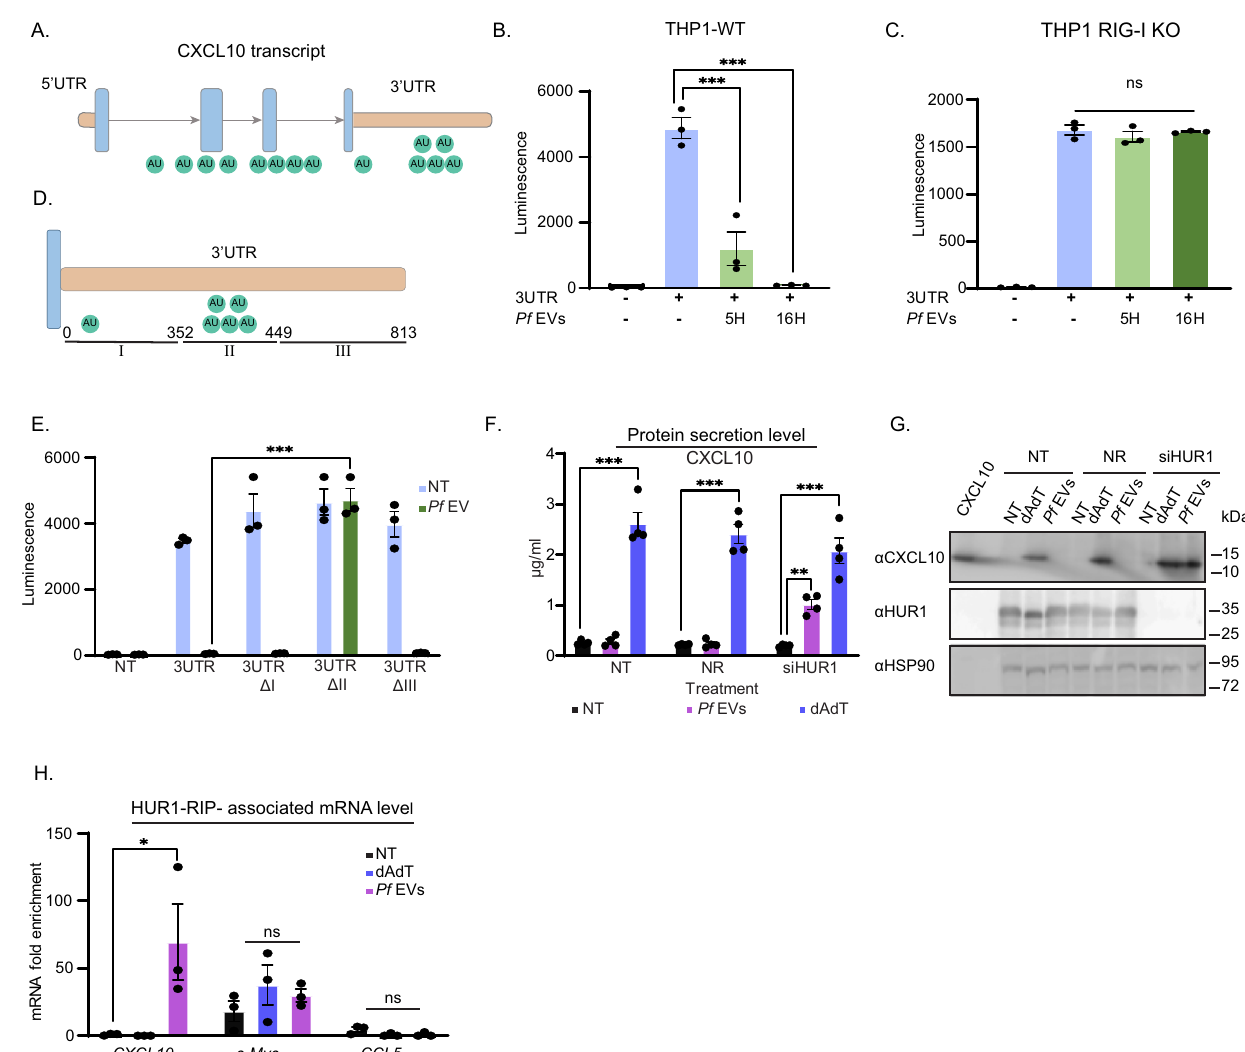
Fig. 4 HUR-1 binds to AU- rich domain in the 3 ′ UTR of the CXCL10 transcript and is involved in translation inhibition. A Schematic illustration of CXCL10 mRNA. Orange squares, blue rectangles, and gray arrows represent the UTRs, exons, and introns of the CXCL10 mRNA, respectively. The green circles illustrate the AU-rich domains predicted by http://arescore.dkfz.de/ analysis. B THP-1 cells were incubated with Pf- derived EVs 5 or 16 h (H) or not treated before the transfection with the CXCL10 -3 ′ UTR-Luc plasmid. 24 h post transfection, the cell media was collected, luciferase levels were measured and normalized to SEAP levels. n = 3 biologically independent experiments, SEM, one-way ANOVA followed by Dunnett ’ s test, (3UTR + Pf EVs 16 h - *** P < 1e-04, 3UTR + Pf EVs 5 h - 3UTR *** P < 1e-04). C THP-1 RIG-I KO cells were incubated with Pf- ring-stage - derived EVs for 5 or 16 h (H) or not treated (NT) before their transfection with the CXCL10 -3 ′ UTR-Luc plasmid. 24 hours post transfection, the cell media was collected and luciferase levels were measured and normalized to the SEAP levels. n = 3 biologically independent experiments, SEM, one-way ANOVA followed by Dunnett ’ s test (ns). D Schematic illustration of the three sub-domains of CXCL10 3 ′ UTR and the cloned deletions Δ I, Δ II, and Δ III. E THP-1 cells were treated with Pf -derived EVs for 16 h prior to transfection with CXCL10 3 ′ UTR-fused-reporter, Δ I, Δ II, Δ III plasmids (NT-not treated cells). 24 hours post-transfection the cells media was collected, Luciferase levels were measured and normalized to the SEAP levels. n = 3 biologically independent experiments, SEM, one-way ANOVA followed by Dunnett ’ s test, ( Pf EVs- 3UTR Δ II - 3UTR *** P < 1e-06). F THP-1 cells were transfected with siRNA for HUR1 or with non-targeting siRNA pool (NR). 48 hours post siRNA transfection, cells were treated with Pf -derived EVs, with poly(dA:dT) and following 24 h post treatments, secreted CXCL10 in the cells media was measured by an ELISA assay, n = 4 biologically independent experiments, SEM, one-way ANOVA followed by Dunnett ’ s test, (NT- Pf -DNA - NT *** P = 1.14e-06, NR- Pf -DNA - NT *** P = 5.14e-07, siHUR1- Pf -DNA - NT *** P = 2.59e-05, Pf -EVs - NT ** P = 0.00907). NT (not treated). G THP-1 cells were transfected with siRNA for HUR1 or with non-targeting siRNA pool (NR). 48 hours post siRNA transfection, cells were treated with Pf -derived EVs, with poly(dA:dT) and following 24 h post treatments, HUR1 reduction and CXCL10 translation was veri fi ed by Western Blot analysis. HSP90 used as a loading control. NT (not treated). Results are representative of at least three independent biological replicates. H THP-1 cells were treated with Pf -derived EVs or transfected with poly(dA:dT). Six hours post treatment, cells were discarded and native RIP assay was performed using anti-HUR1 antibody or anti- HSP70 as negative control. Real-time PCR analysis for CXCL10, CCL5 (as negative control) and c-Myc (as positive control) was performed on the input (pull down) of the RIP samples, n = 3 biologically independent experiments, SEM, one-way ANOVA followed by Dunnett ’ s test, ( Pf EVs -* P = 0.0427). NT (not treated). Source data are provided as a Source Data fi